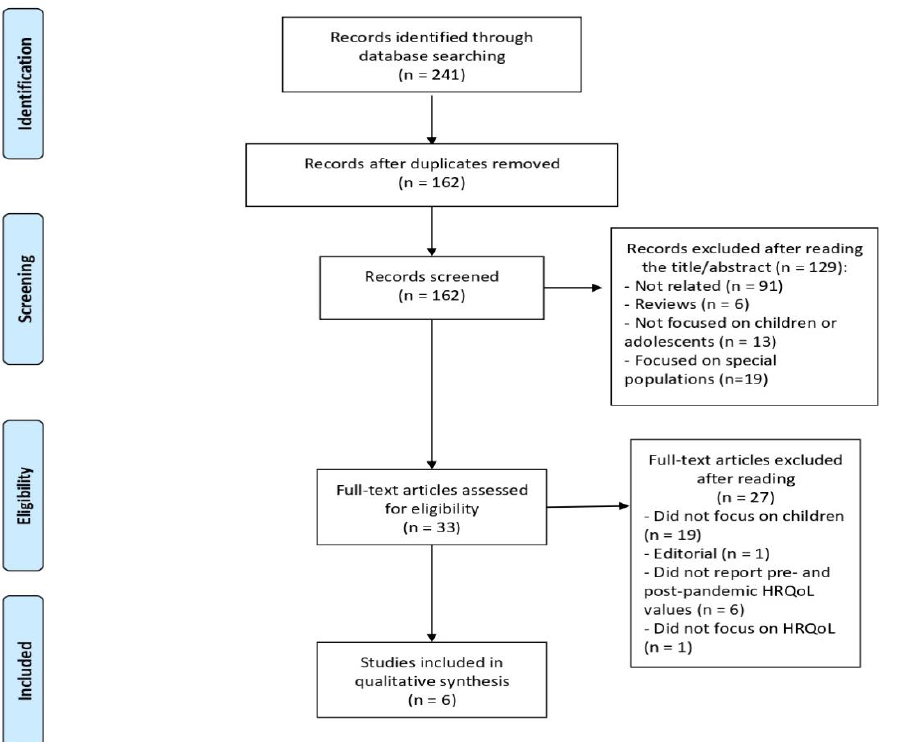
Figure 1. Flow chart of the selection process in this systematic